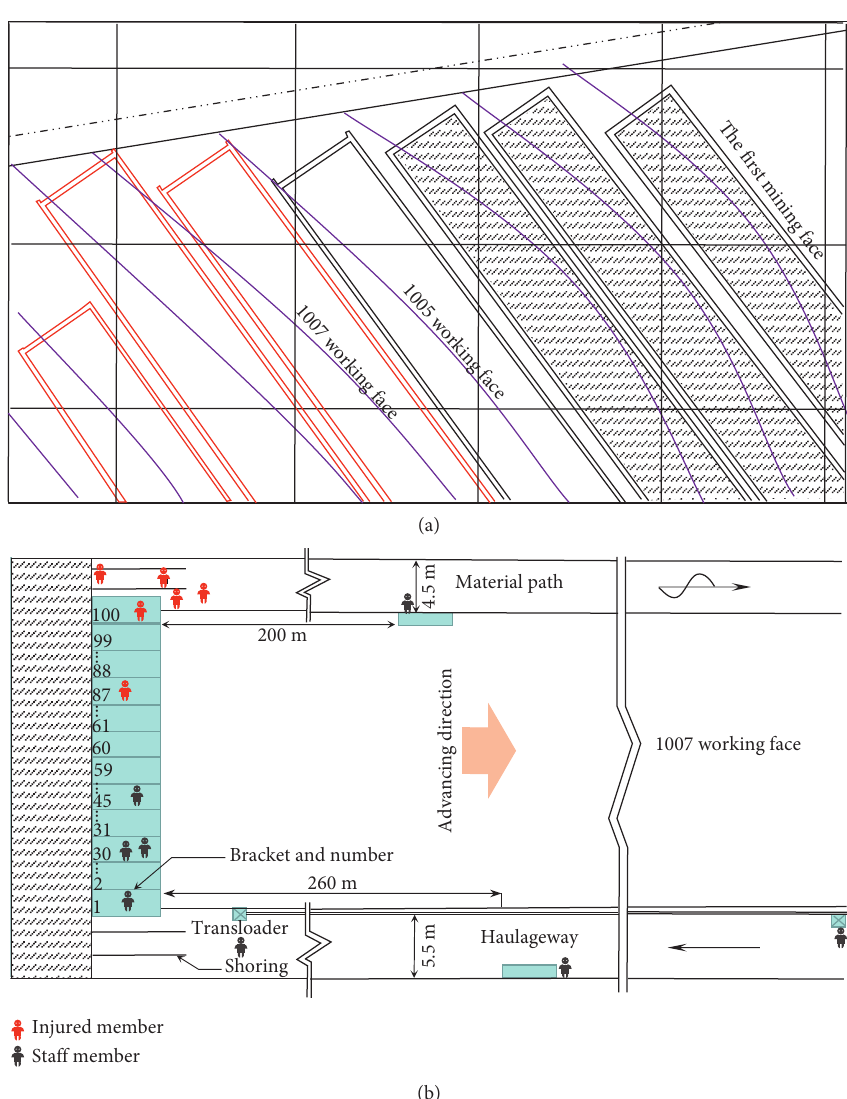
Figure 2: Layout of the working face and incidents’ indication. (a) Working face layout. (b) Schematic illustration of the first accident site.